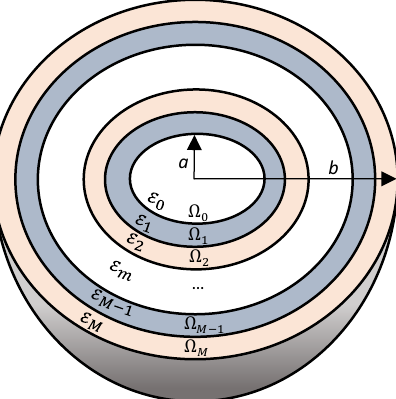
Figure 3. Schematic of a layered spherical isotropic shell consisting of M layers filling with alternat- ing